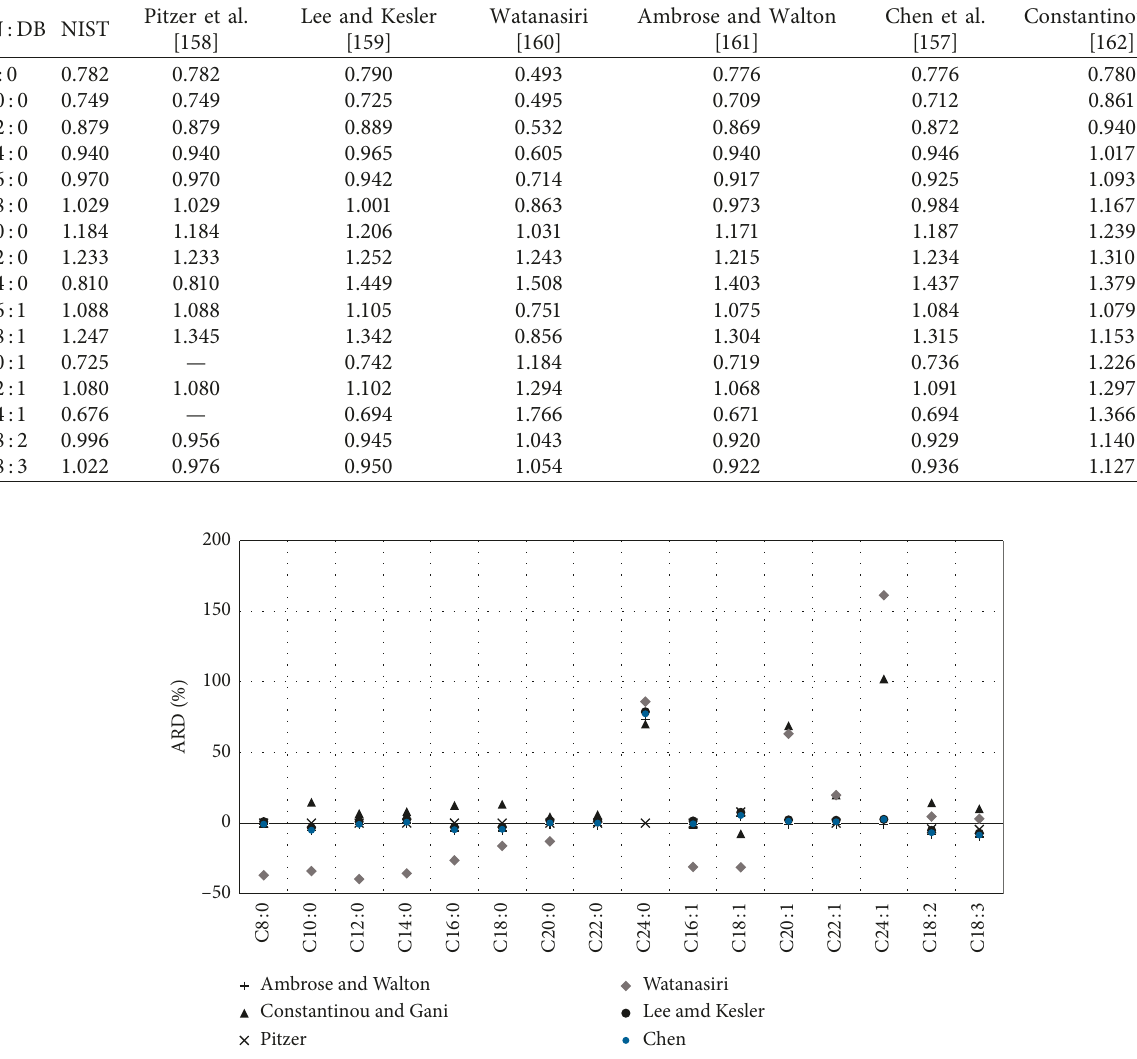
Figure 9: Absolute relative deviation of estimation of the acentric